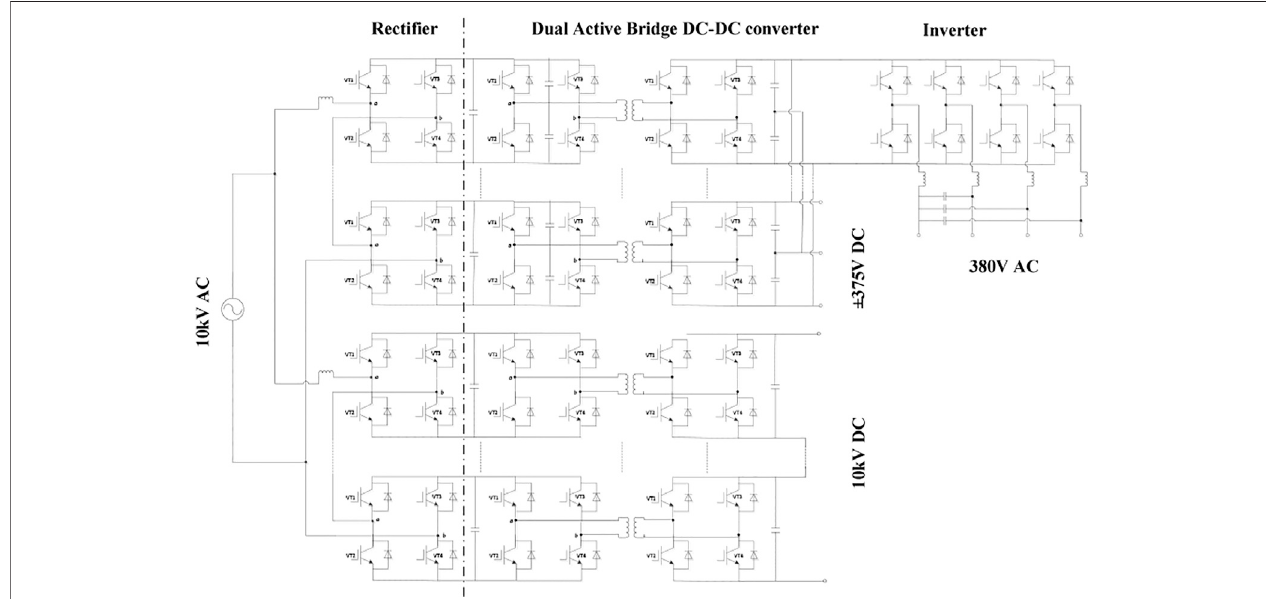
FIGURE 9 | Topology of four-port